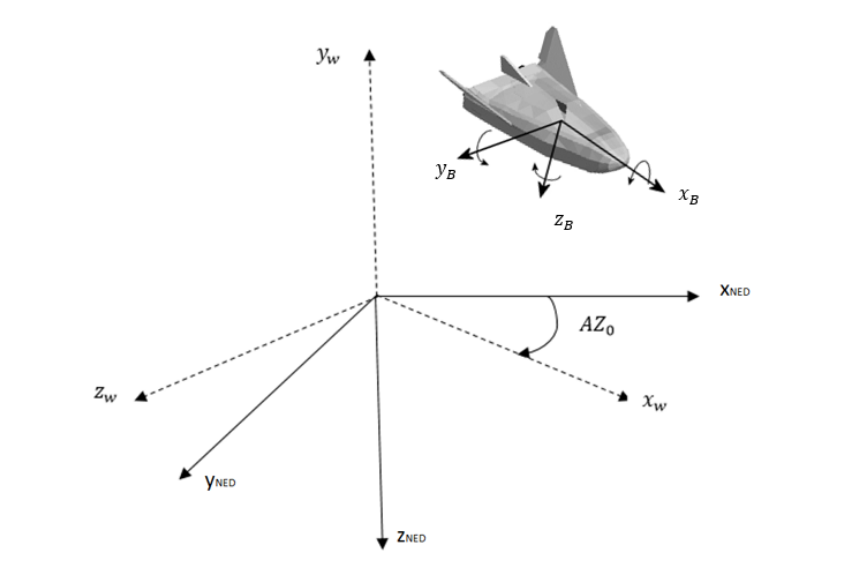
Figure 1. The three employed reference